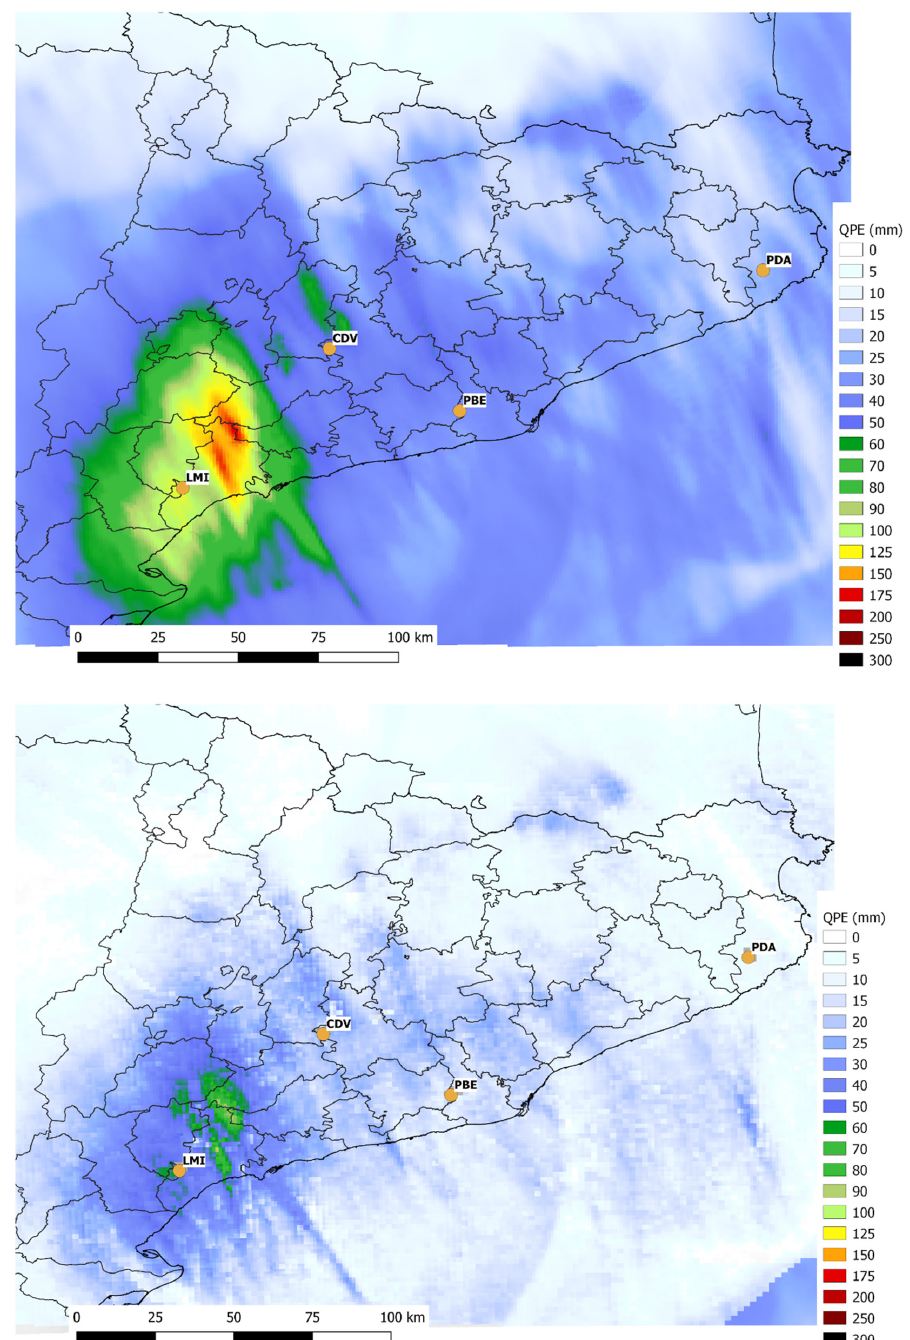
Figure 8. Top : QPE with complex (EHIMI) corrections for the 22 October 2019 event. Bottom : Figure 8. Top: QPE with complex (EHIMI) corrections for the 22 October 2019 event. Bottom : Difference in the QPE 2 field Difference in the QPE 2 field with respect to the uncorrected one, QPE 1 (Figure with respect to the uncorrected one, QPE 1 (Figure 7).